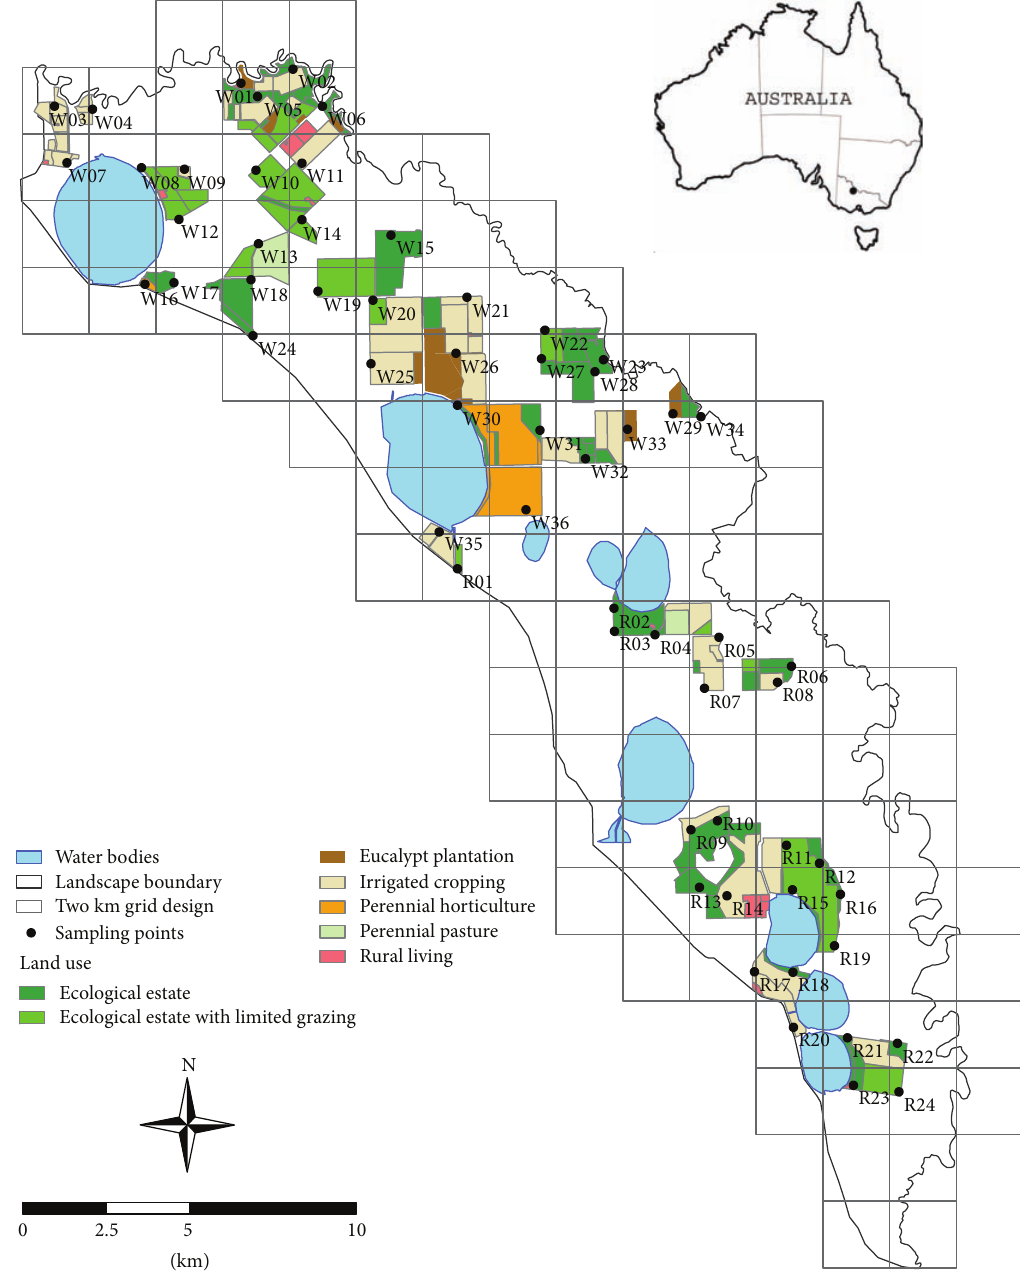
Figure2:Studyarealocation,thedistributionofproposedlandusesinthefuture(25-year)land-usescenario(coveringatotalareaof6,441 ha) and the associated irregular-grid used to sample soils in this